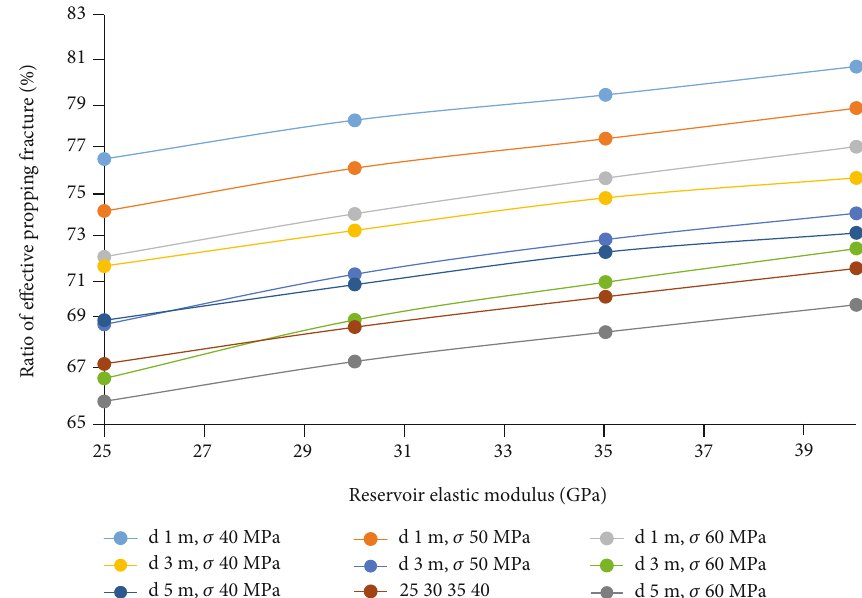
Figure 41: The in fl uence of reservoir elastic modulus at 8 mm height and di ff erent diameters on the ratio of e ff ective supporting fractures.